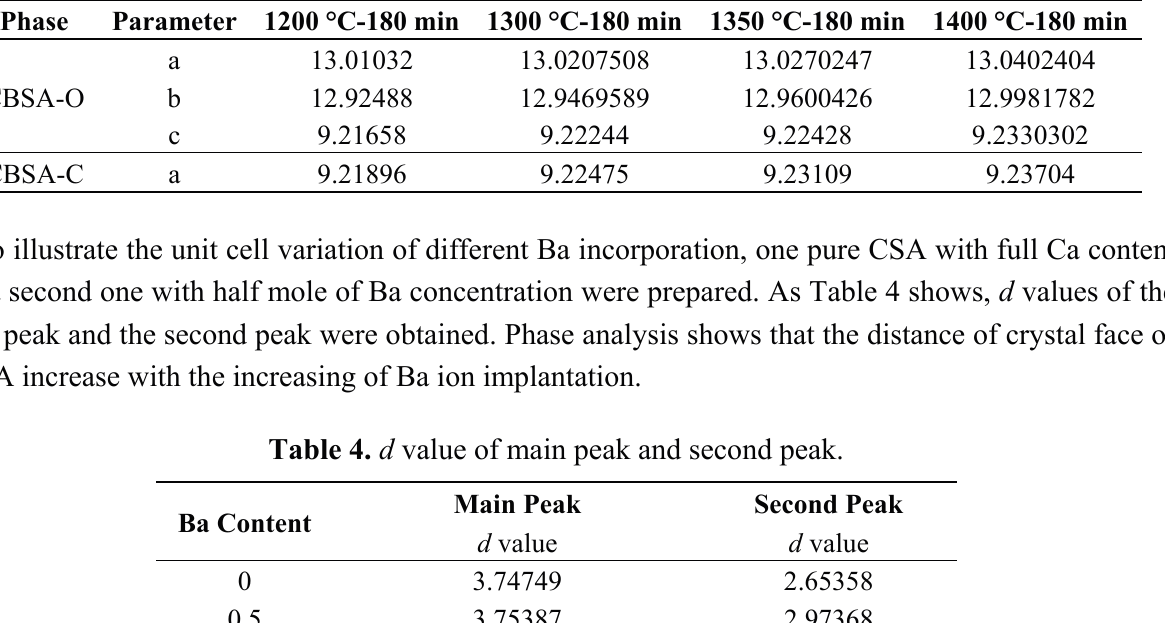
Figure 2. Fitting effect of CBSA samples sintered at 1400 °C for 180 min. Table 3. Unit cell parameters of CBSA samples.